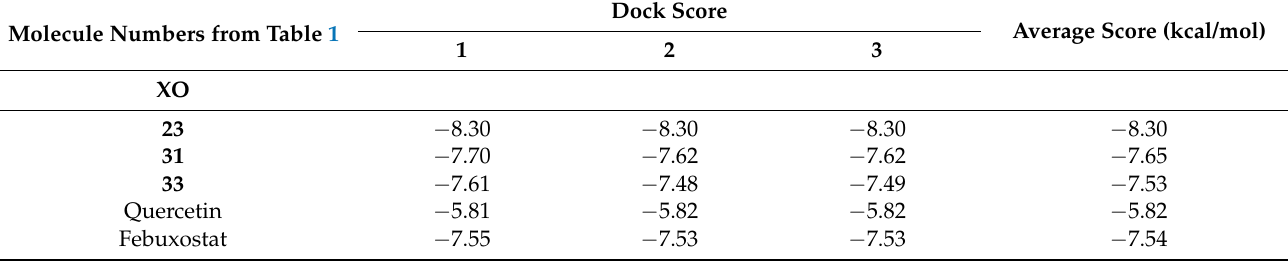
Table 5. Average docking scoring functions (kcal/mol) of the most promising compounds from E. divinorum with xanthine oxidase, heat shock protein 90 (Hsp90), and inducible nitric oxide synthase